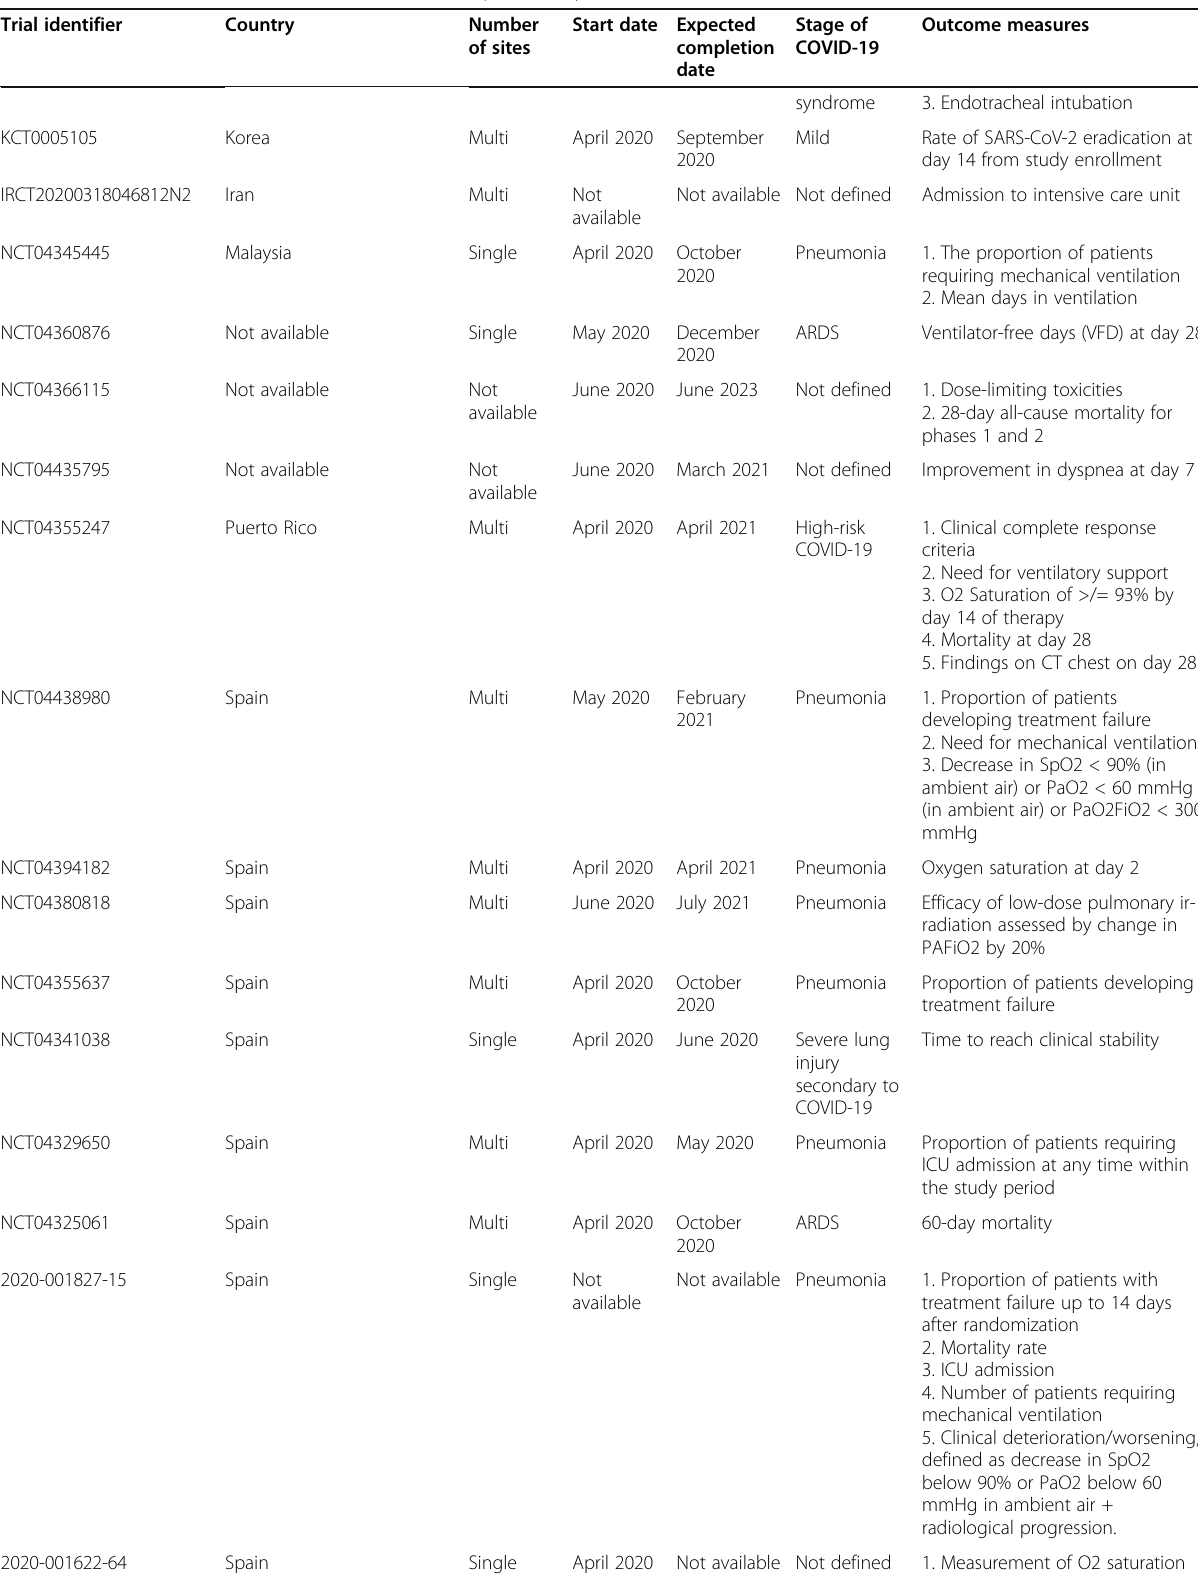
Table 1 General characteristics of the included trials